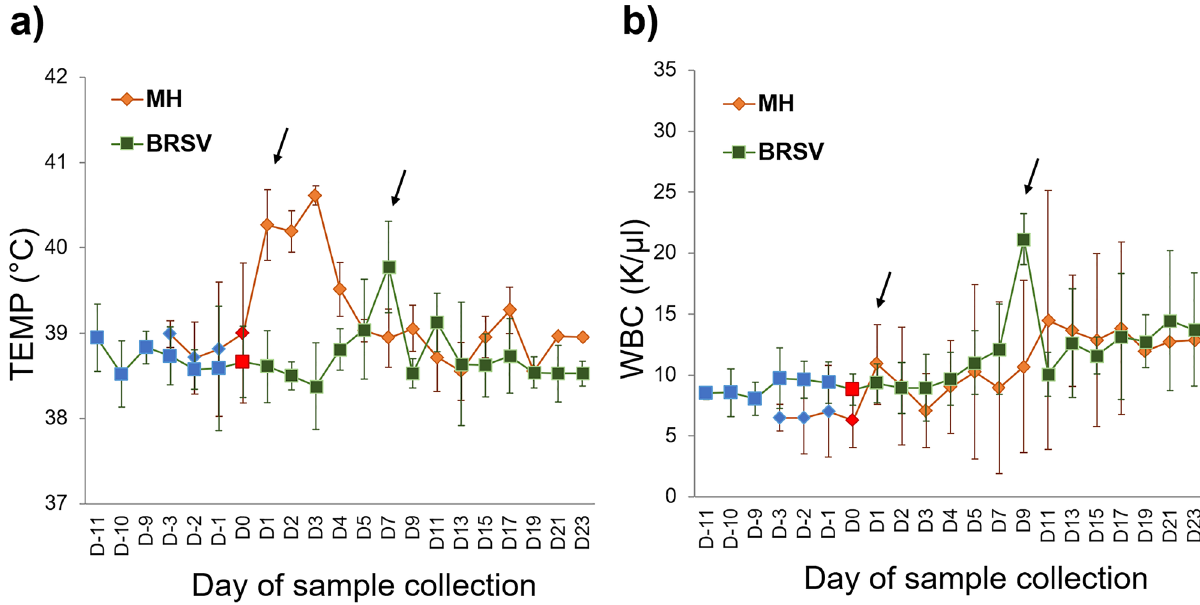
Figure 1. Dairy calves’ responses to viral (n = 5) and bacterial (n = 5) infection. Calves were challenged with the infectious agent on D0. ( a ) Daily rectal temperature (TEMP, °C) displayed as Mean ± SD. ( b ) WBC